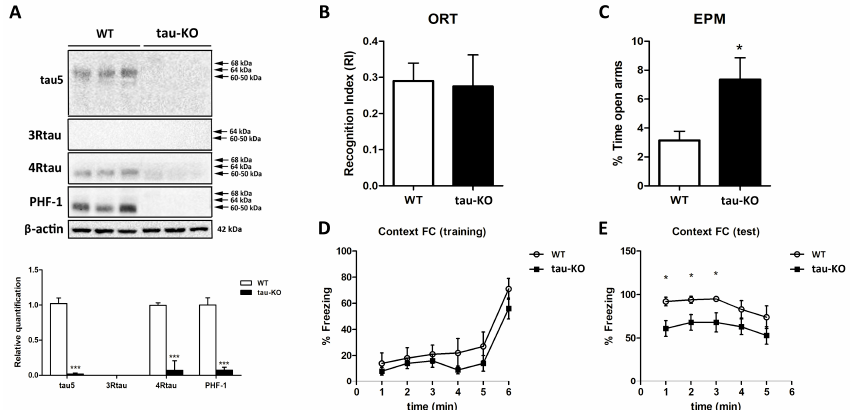
Figure 1. ( A ) Western blots of brain homogenates of WT mice show immunoreactive bands at the appropriate molecular weight for antibodies tau 5, 4R tau, and PHF1; Western blots for 3R tau are negative. As expected, Western blots to tau 5, 4R tau, and PHF1 (and 3R tau) of brain homogenates from tau-KO mice are negative. Molecular weights pointed with arrows indicate the theoretical positions of all tau isoform bands in an immunoblotting membrane. A densitometric study of the bands confirms significant differences between WT and tau-KO mice, *** p < 0.001. ( B ) A two-object recognition test reveals no differences between WT and tau-KO mice. ( C ) The results of the elevated plus maze reveal a reduced anxiety-like behavior in tau-KO mice, spending more time in the open arms compared to WT ( p < 0.05). ( D ) No differences are seen in the training trial of the contextual fear conditioning test. ( E ) However, transient but significantly less freezing occurs in the first 3 min of re-exposure to the aversively conditioned context in tau-KO mice (* p < 0.05). Transcriptomic analysis using RNA-seq revealed differentially expressed genes in tau-KO mice compared with WT. Age and sex were not relevant for the analysis. After filtering, 12,410 genes were not significantly altered; 69 were downregulated and 105 were upregulated. Deregulated transcripts are graphically illustrated in the heat map represen- tation at a probability of an adjusted p -value < 0.05 (Figure 2A). Enrichment analysis against the Gene Ontology database ( p < 0.05) identified the main altered genes corre- sponding to (i) synaptic structures, (ii) neuron cytoskeleton and transport, and (iii) extra- cellular matrix components (Figure 2B). Deregulated genes are listed in Supplementary Table S1.